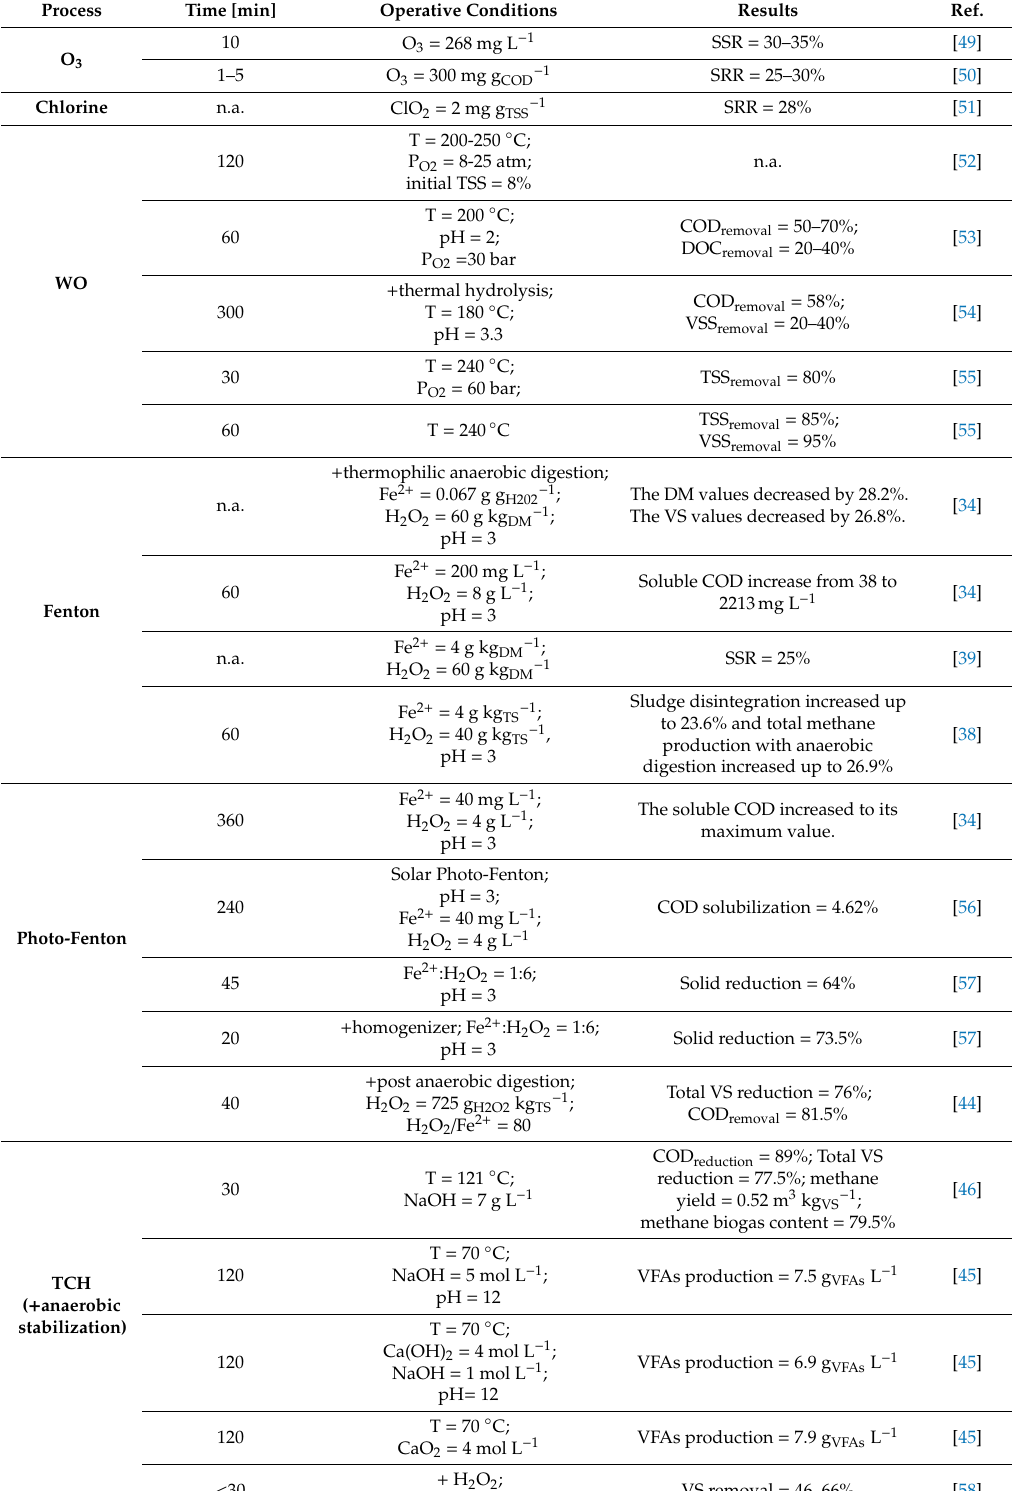
Table 1. Several applications of chemical